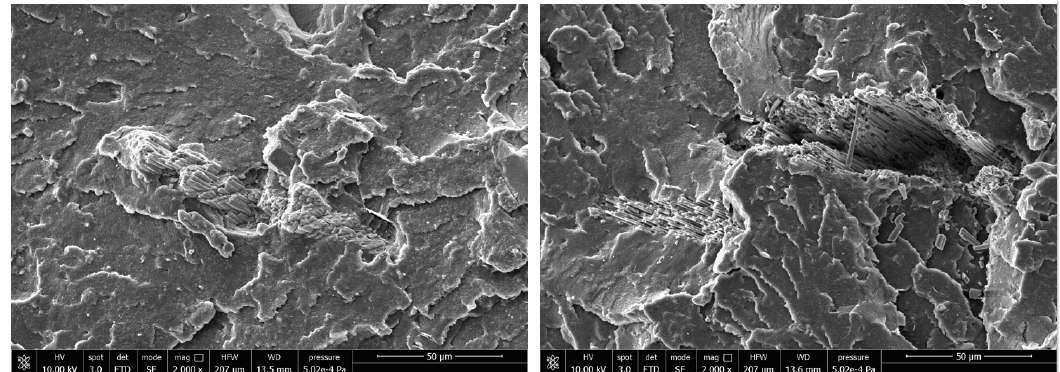
Figure 10. 2000× magnification of interaction matrix/filler for base + 10 (left) and base + 20 (right) Figure 10. 2000 × magnification of interaction matrix / filler for base + 10 ( Left ) and base + 20 ( Right )